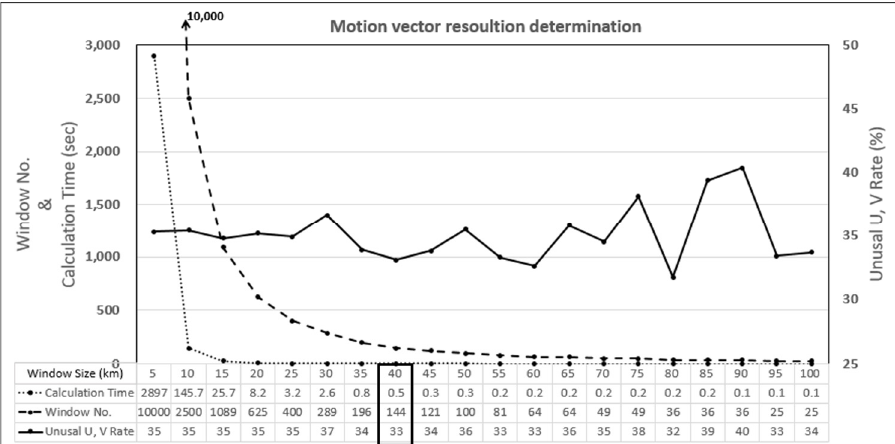
Figure 3. The calculation time (small dotted line) required to create the vector intersection of each pixel, the number of windows (thick dotted line) in the analysis field, and the unusual u and v vector generation rate (solid line) according to resolution (window size) when running the ACTION algorithm. Appropriate resolution selection conditions (black-outlined data) suitable for motion vector generation (computation time ≤ 30, number of windows 100 or more, minimum abnormal u and v vector generation rate).